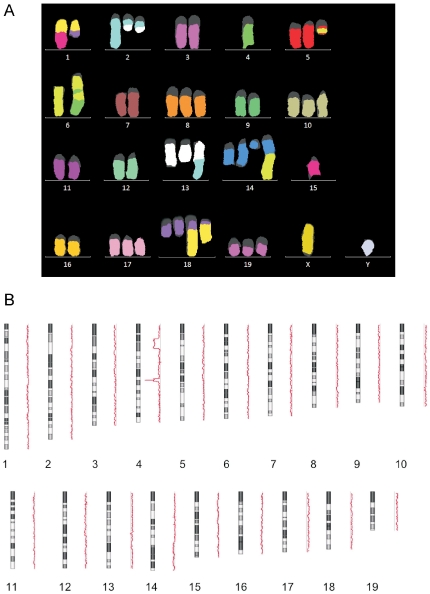
Chromosomal analyses of MM cells from an Arf-deficient mouse.
A, mFISH revealed one or more copies of 1;15, 1;18, 2;13, 5;6, and 6;14 rearrangements; der(6) composed of (from centromere to telomere) segments of chromosomes 6, 4, 6, and 4; deletion of chromosome 14; and trisomies of chromosomes 8, 10, 17 and 19. B, aCGH analysis showed gains of chromosomes 8, 10, 13, 17, 18, and 19; and deletions of two regions of chromosome 4, one of which (lower) represents a homozygous deletion encompassing the Cdkn2a/Arf locus embedded within a hemizygous deletion.